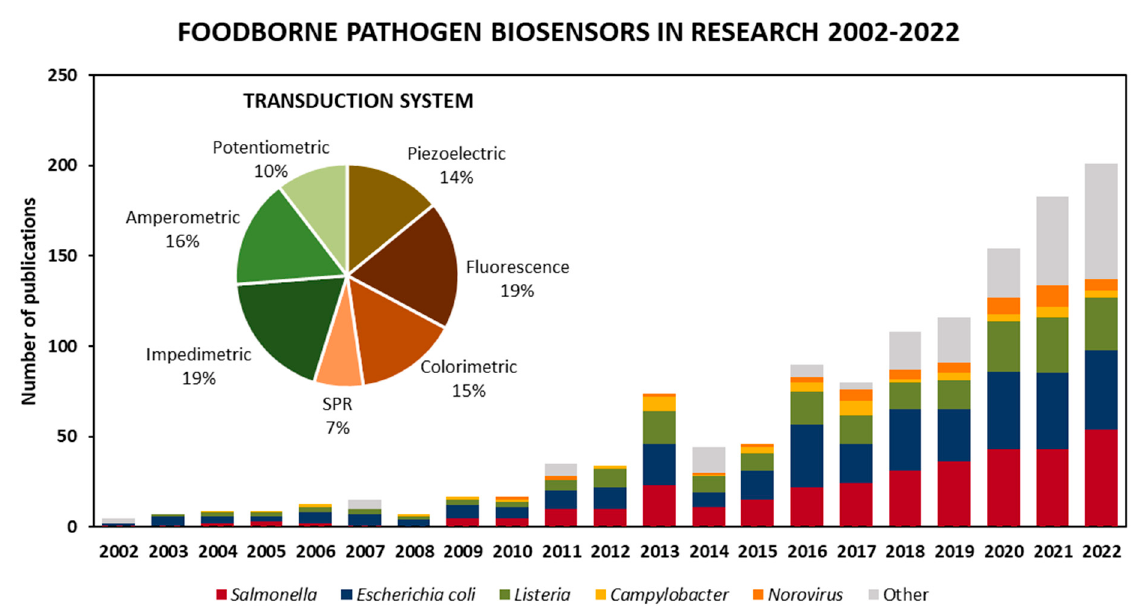
Figure 2. Published articles on biosensors for the detection of foodborne pathogens in the literature in the period of 2002–2022. Values obtained by limiting “foodborne pathogen detection” and synonyms as a keywords article search in Scopus from 2002 to 2022 to biosensors, then classifying the 1167 articles by target foodborne pathogen and transduction techniques.